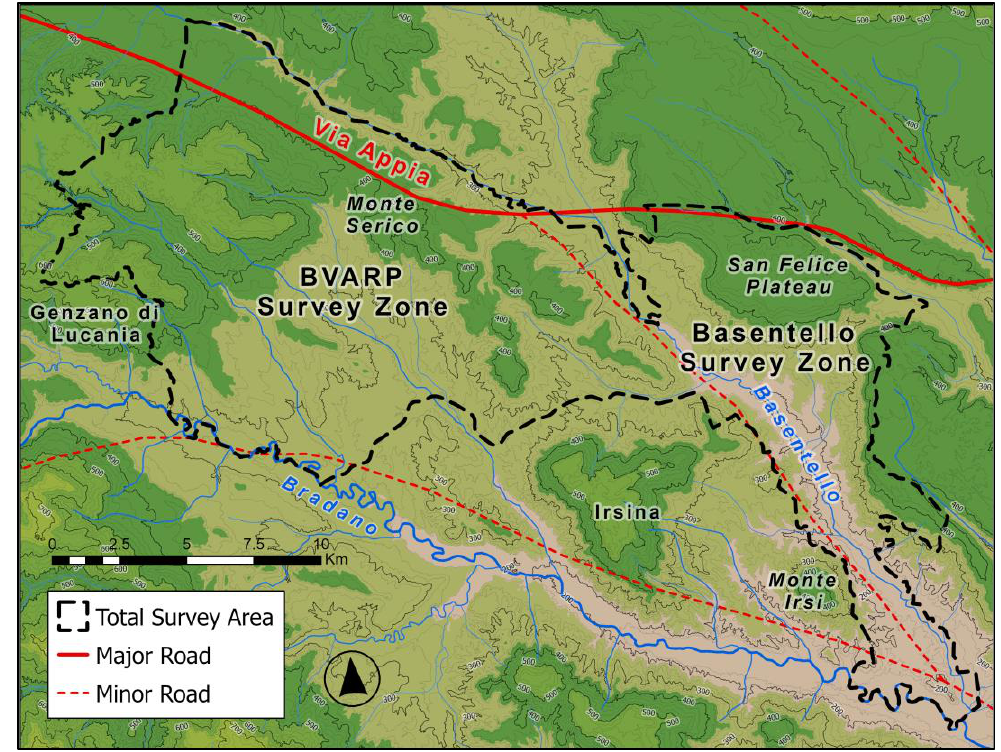
Figure 2. The Basentello Valley survey